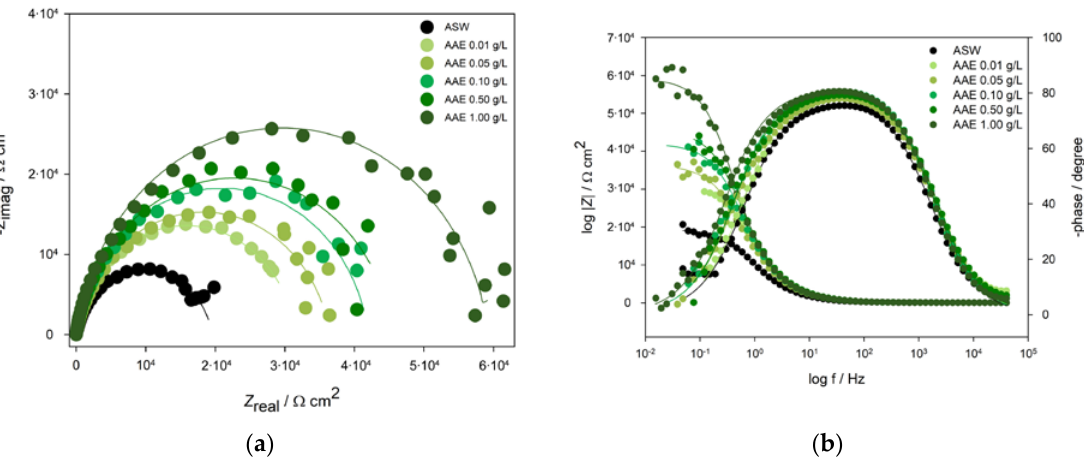
Figure 3. Nyquist ( a ) and Bode ( b ) plots of aluminium 5083 alloy recorded in ASW without and with the addition of different concentrations of Artemisia annua L. extract (AAE, shown in figure). Solid lines represent simulated data (χ 2 ≤ 10 −4 , with acceptable error of fitting elements ±5%).